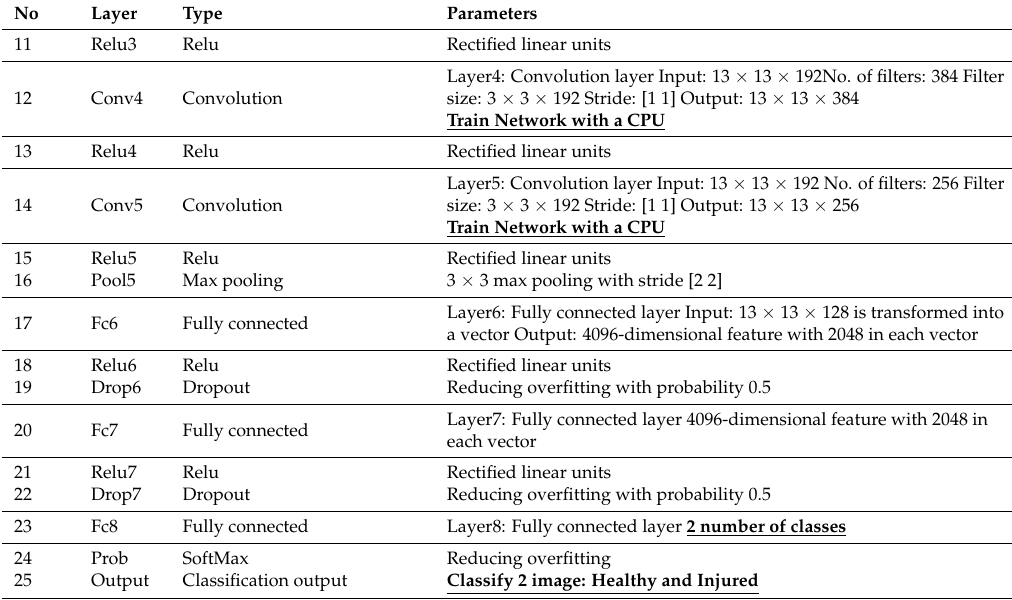
Classify 2 image: Healthy and Injured